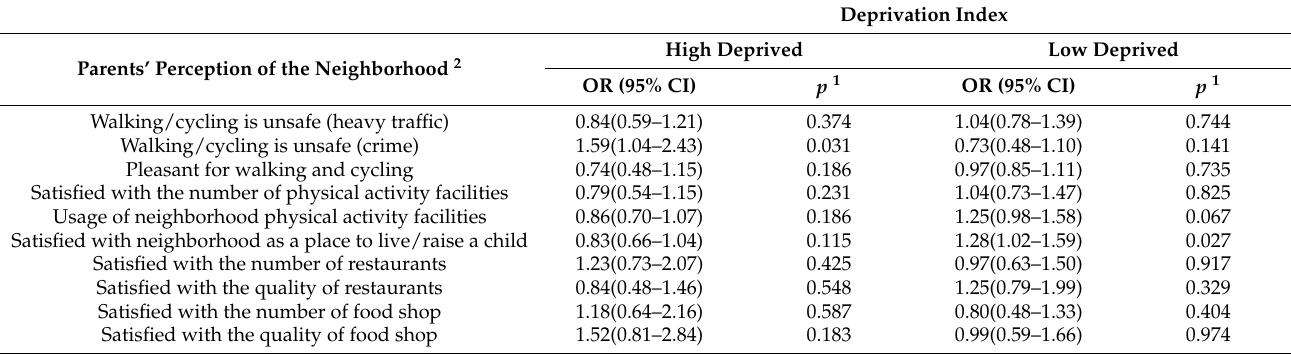
Table 3. Associations between parents’ perceptions of their neighborhood and deprivation